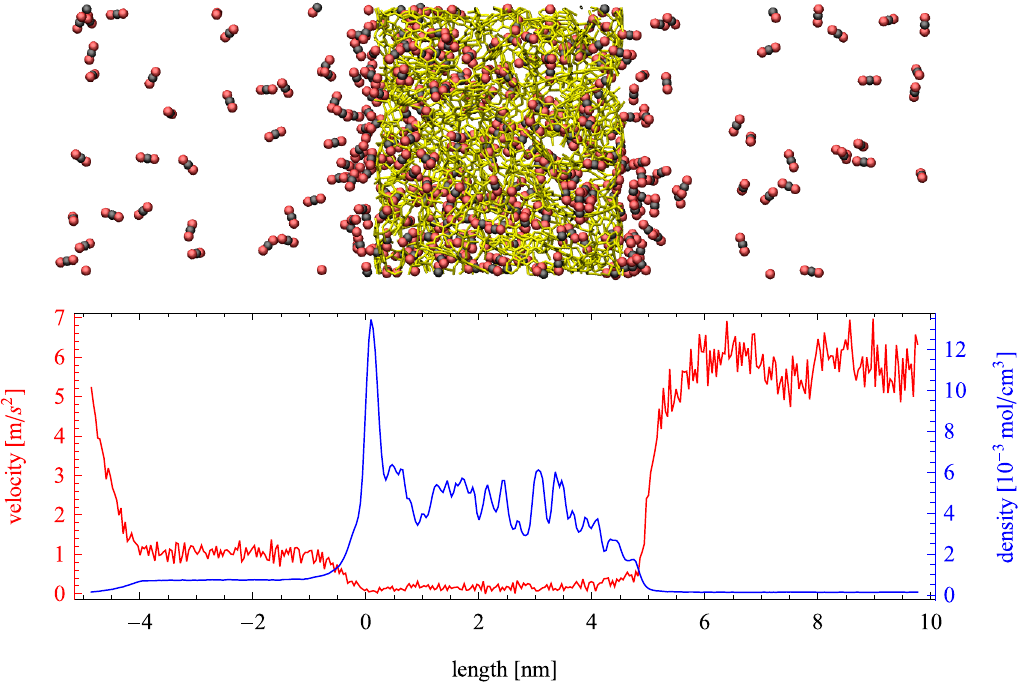
Figure 2. (Top) Snapshot of an instantaneous configuration of the simulation cell. Periodic boundary conditions are applied in all directions and an external force applied to the fluid molecules in the left boundary. Carbon dioxide molecules are depicted by black and red, while a stick representation of a slab of PIM-1 is shown in yellow. (Bottom) Average velocity profile in the direction of transport (red) and the fluid density profile (blue) across the simulation cell. Density within the porous region is referred to the total volume, including the